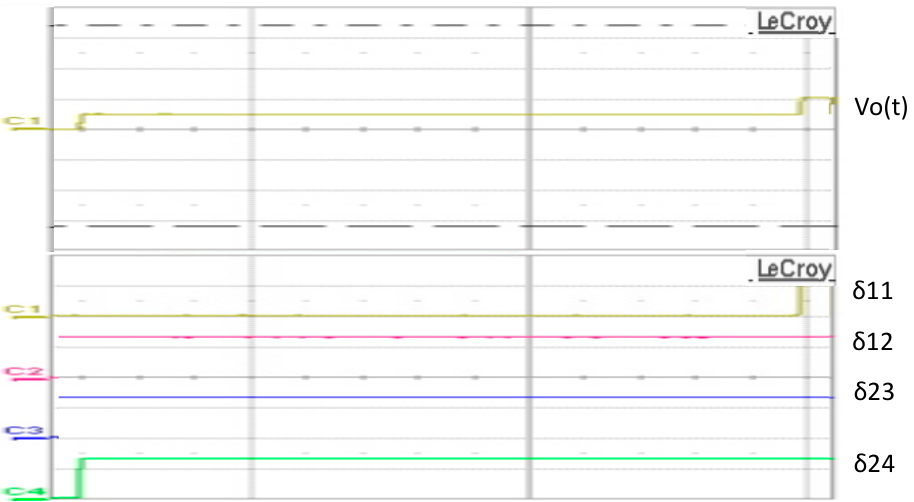
Figure 23. Output voltage during OPT-PWM control.